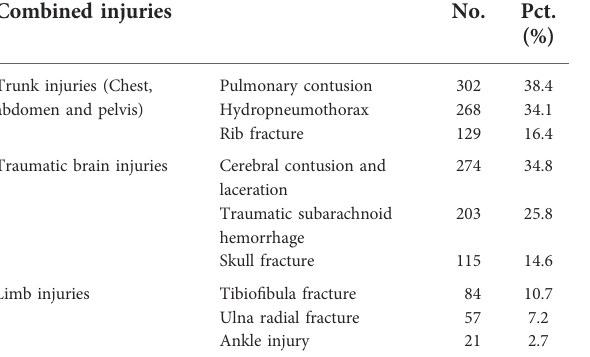
TABLE 3 Clinical complications of 385 TSCI patients. No.